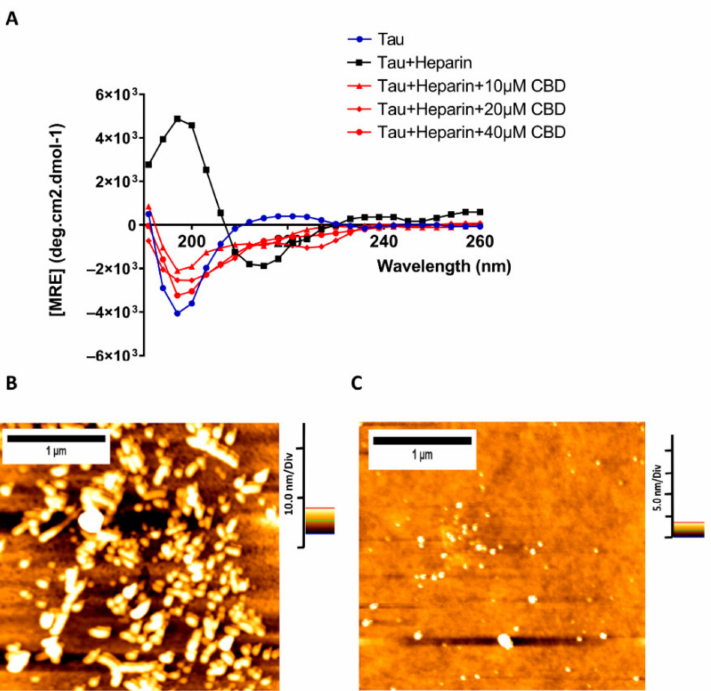
Figure 3. CBD is capable of reducing tau protein polymerization. ( A ) Far-UV CD spectra of 20 µ M heparin-induced tau protein in the absence and presence of three concentrations of CBD (10, 20, and 40 µ M) to monitor the changes in the secondary structures of tau aggregation after 72 h. Three independent experiments ( n = 3) were performed to record the spectra. ( B ) AFM image of heparin-induced tau protein. ( C ) AFM image of heparin-induced tau protein in the presence of 40 µ M